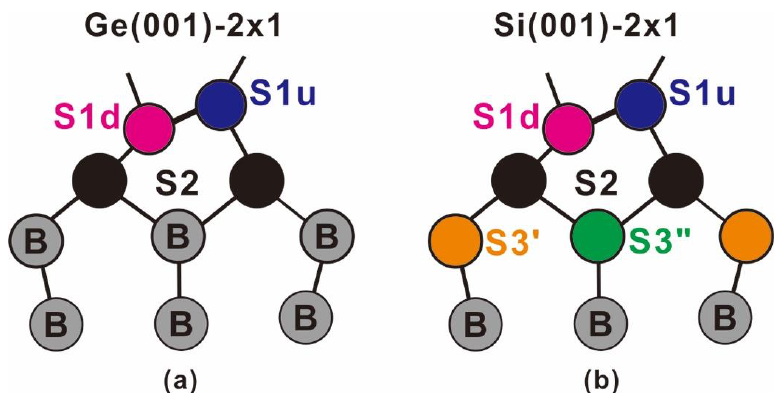
Figure 1. Schematic side-view drawings of ( a ) buckled Ge(001)-2 × 1 and ( b ) buckled Si(001)-2 × 1 surface. Symbols S1u, S1d, S2, and S3 stand for the up-dimer atom, down-dimer atom, atoms in the second surface layer, and atoms in the third surface layer, respectively. In Ge(001)-2 × 1, the S3 atoms show one electronic environment, but in Si(001)-2 × 1, they are differentiated by S3 ’ and S3 ’’ electronic environments.